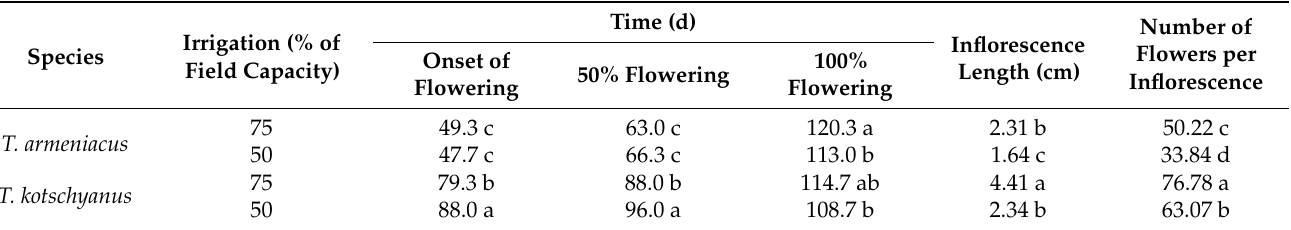
Table 1. Effect of irrigation regime on time to flowering (initiation, 50 and 100%) and two key inflorescence characteristics of two Thymus species. The latter was evaluated at 100% flowering. Within each column, different letters indicate significant differences ( n =